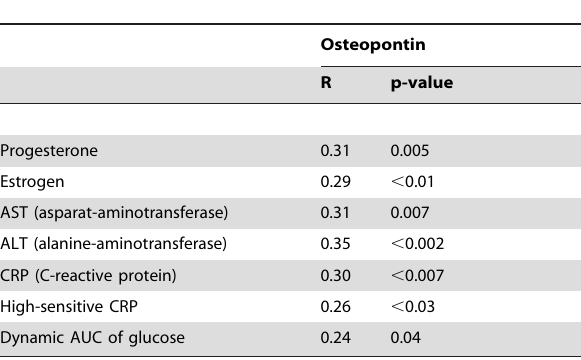
Table 2. Correlation analyses of osteopontin during pregnancy in the whole study